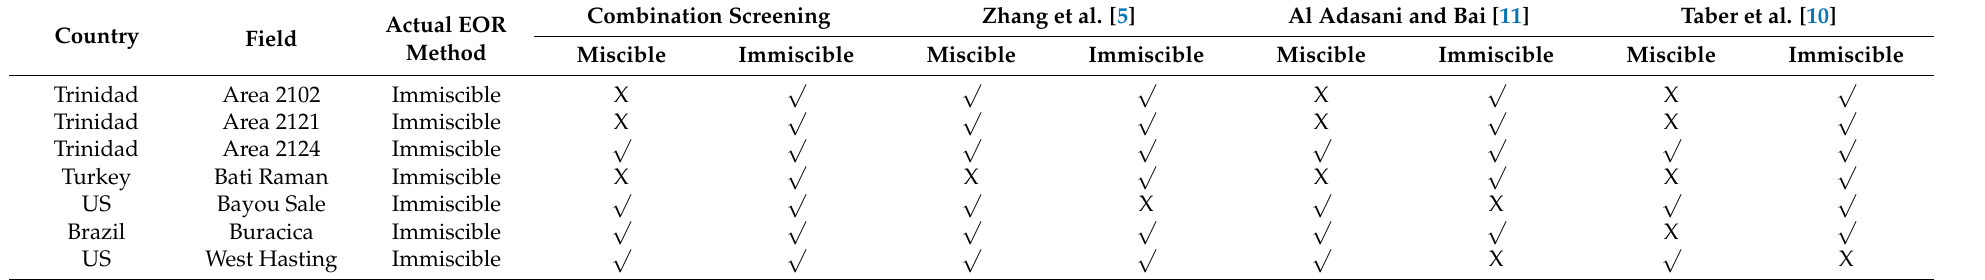
Table 8. Results of the screening model implementation on immiscible CO 2